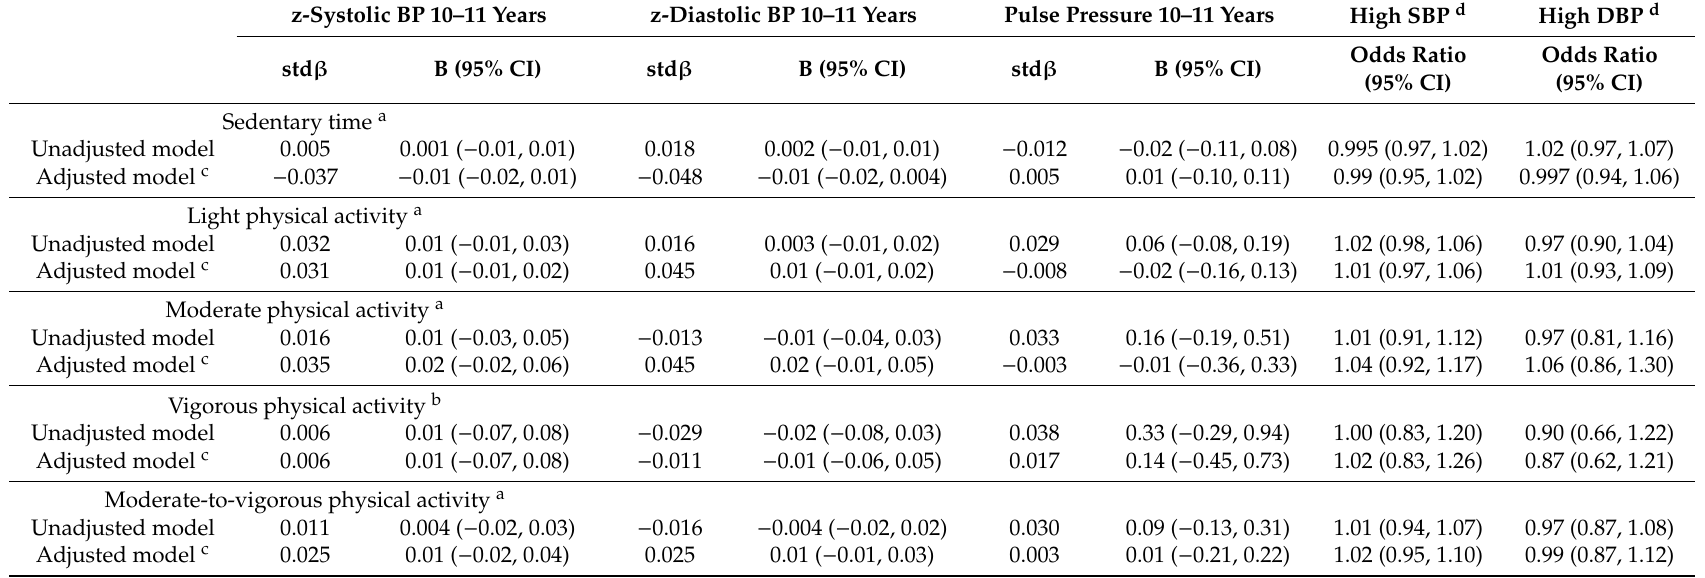
Table 4. Prospective associations of physical activity behaviours with blood